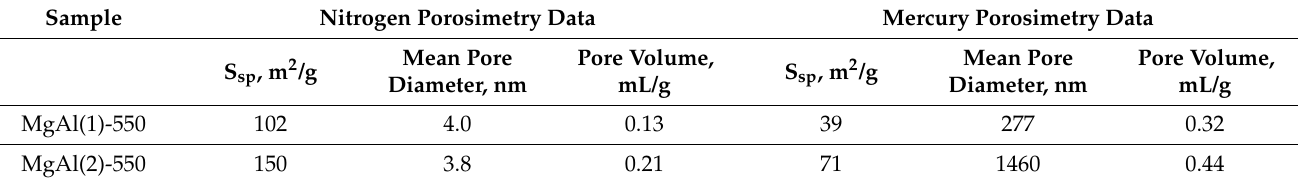
Figure 4. Nitrogen ( A ) and mercury ( B ) porosimetry curves of the samples: 1—MgAl(1)-550; 2—MgAl(2)-550. Table 1. Textural characteristics of the